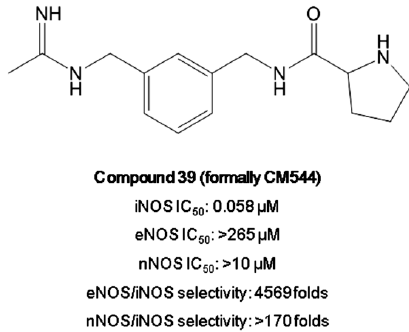
Figure 2. Compound 39 (formally CM544) chemical structure and activity towards NOSs.